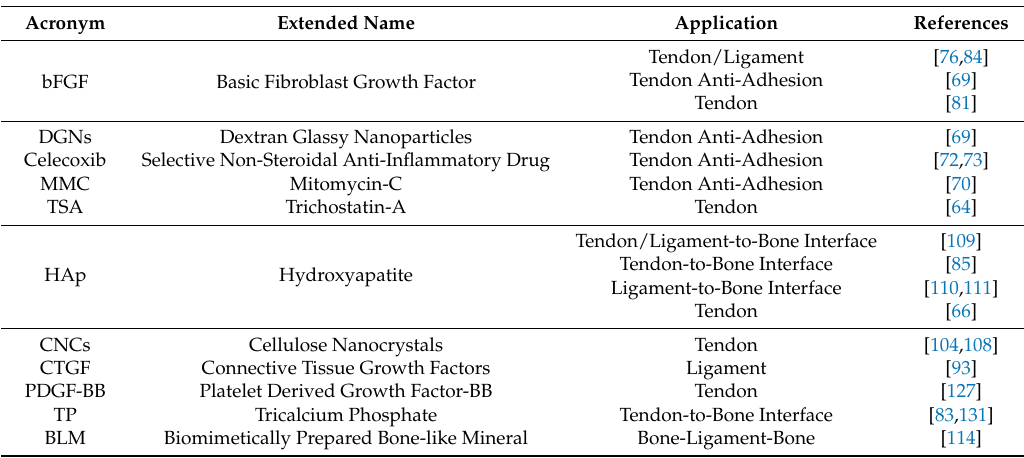
Table 3. Particles and drugs to load electrospun fibers and their applications in tendon and ligament tissue